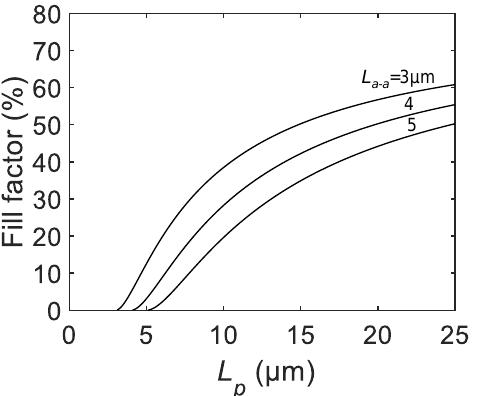
Figure 2. The calculated FF as a function of the SPAD pixel pitch L p for active-to-active distances L a − a = 3, 4, 5 µ